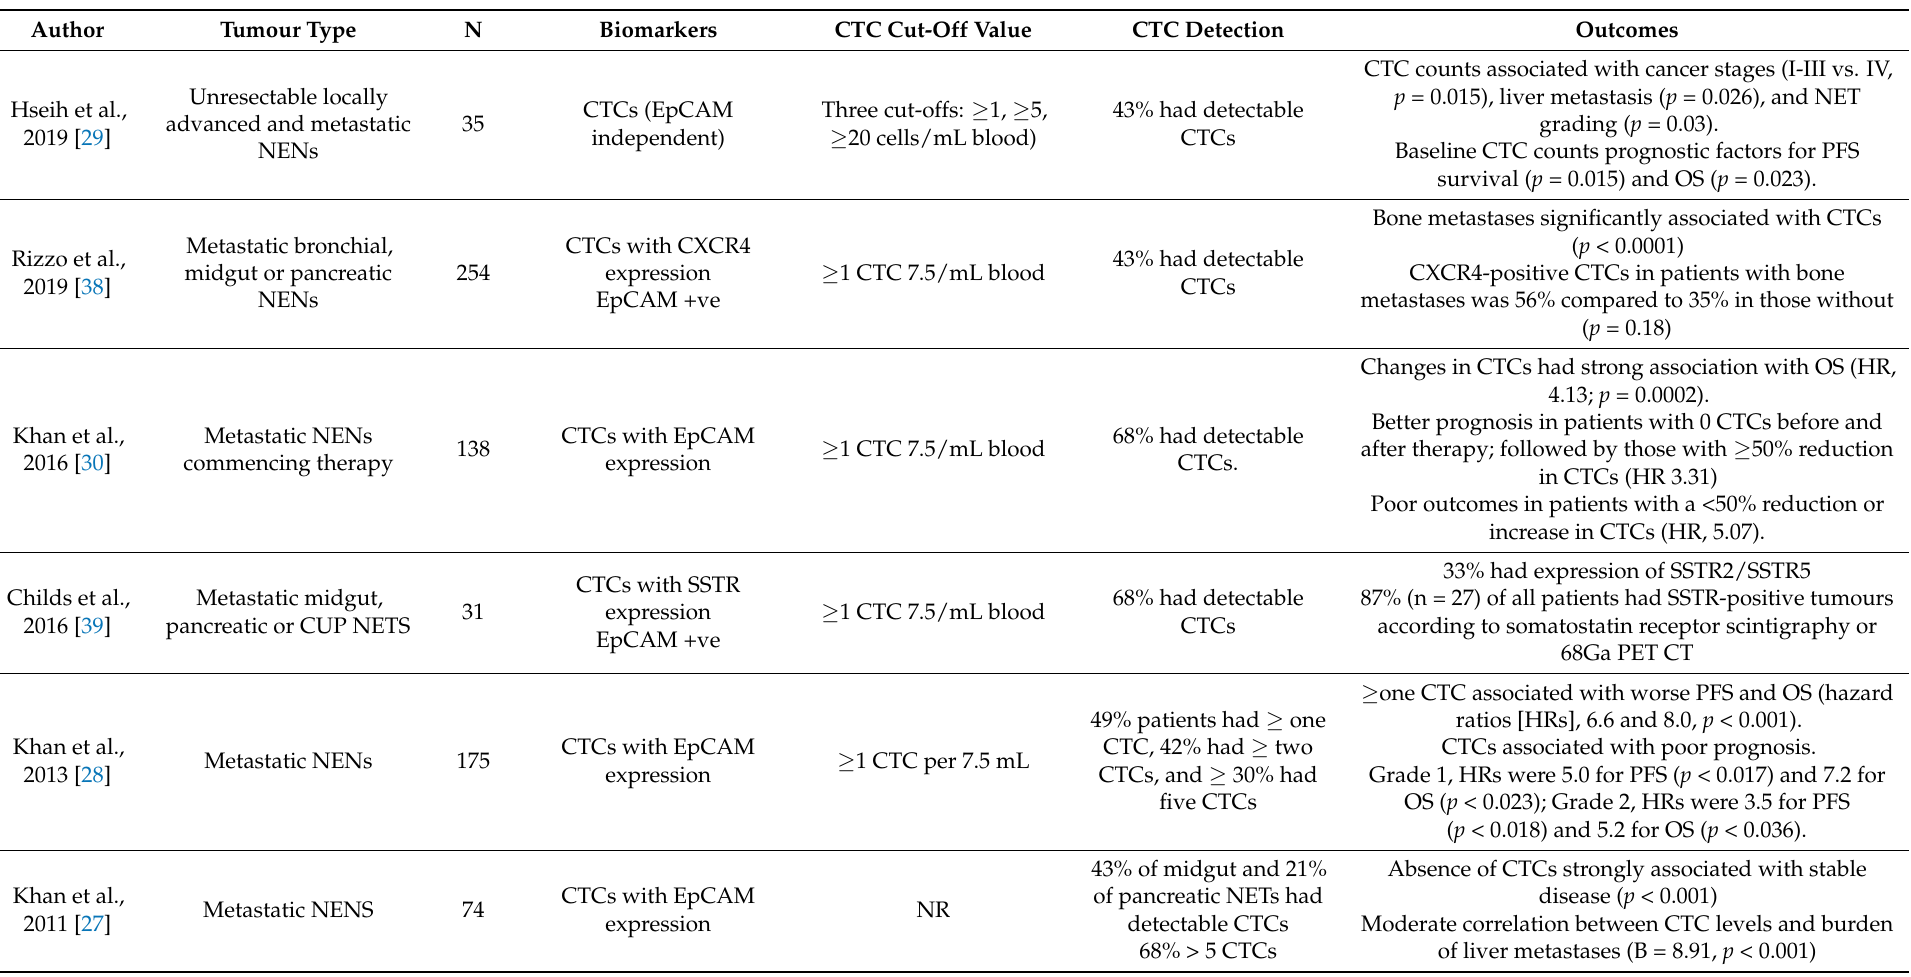
Table 1. Summary of relevant evidence of potential utility of circulating tumour cells (CTCs) in patients with neuroendocrine neoplasms